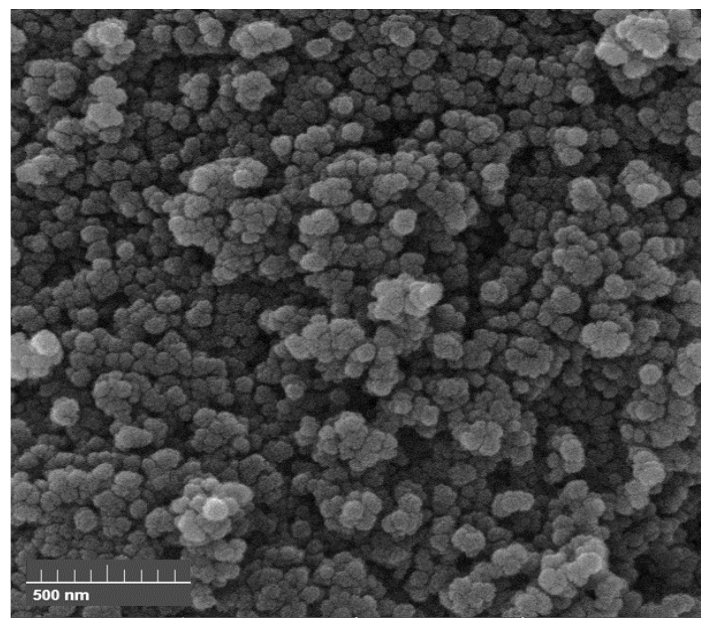
Figure 1. The SEM image of the anatase TiO 2 nanoparticles at a magnification of 100,000 × . The PEO coatings’ surface morphology was observed using the SEM images (captured Table 1. The chemical composition of the PEO process electrolytes for each sample code. by a QUANTA 200 FEI microscope, made in Hillsboro, OR, USA). The SEM images of the PEO coatings were further analyzed using Microstructural Image Processing